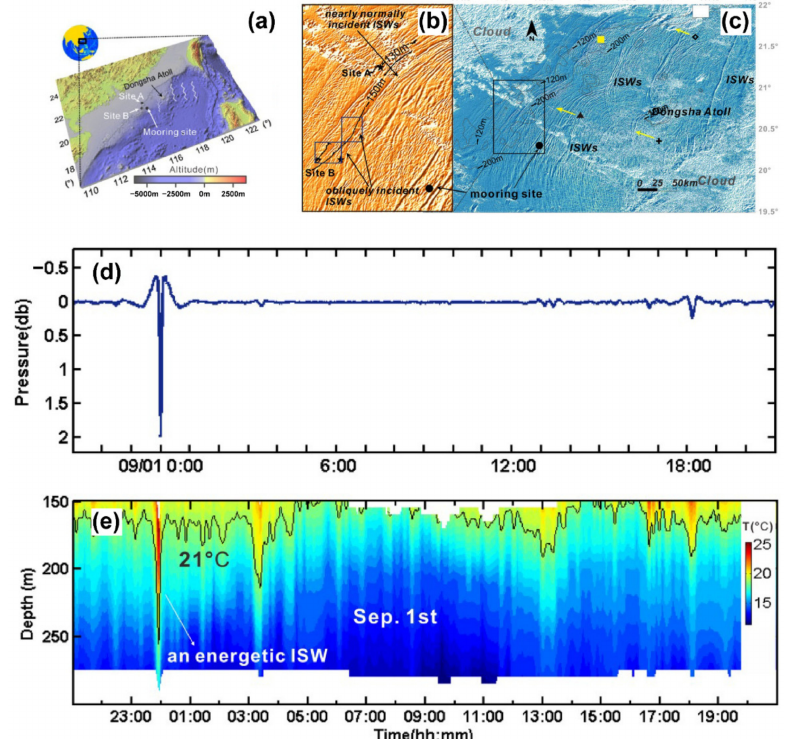
Figure 7. Seafloor pressure of obliquely incident ISWs in the northern South China Sea. ( a ) Location of the mooring site. ( b ) Expansion of boxed region in ( c ). The obliquely incident ISWs (deep brown imprints) near the mooring site are shown in the amplified MODIS image. ( c ) The MODIS image illustrates the ISWs’ direction. Approximately 2.5 kPa of pressure changes at 10 m above the bottom at the mooring site ( d ), when the largest fluctuation of 21 ◦ C isotherms is down about 80 m ( e ), reflecting a crossing energetic ISW propagation. Panels ( a – e ) adapted from Ma et al. [19], with permission from